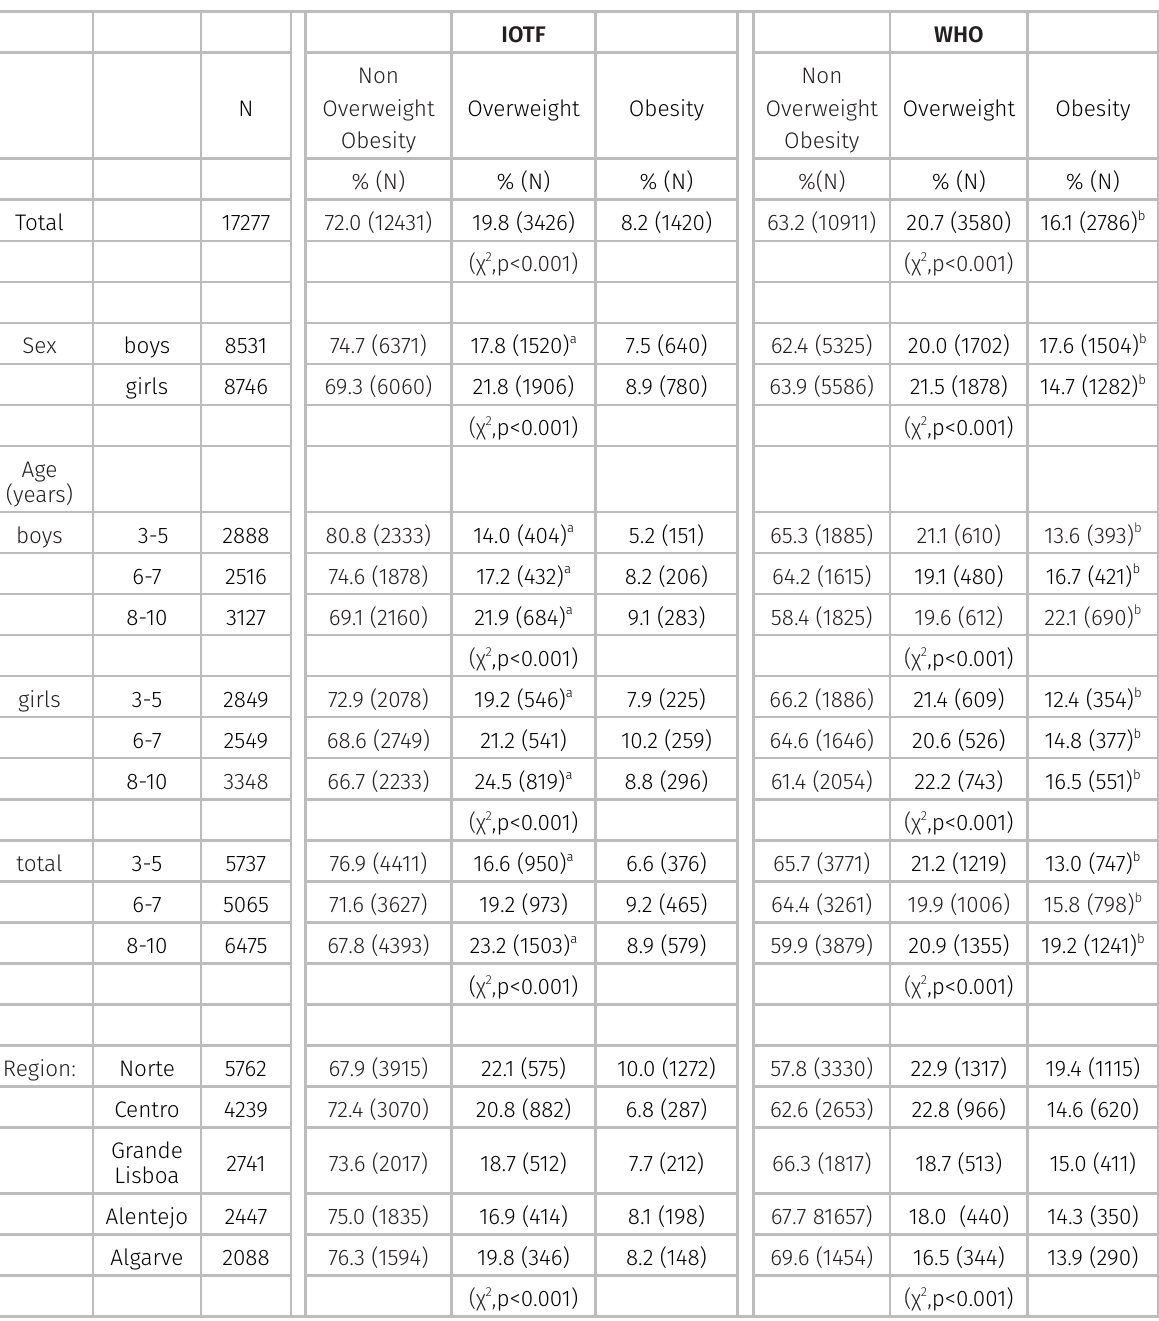
Table I. Prevalence of overweight and obesity by sex, age group and mainland region, according to IOTF and WHO criteria.